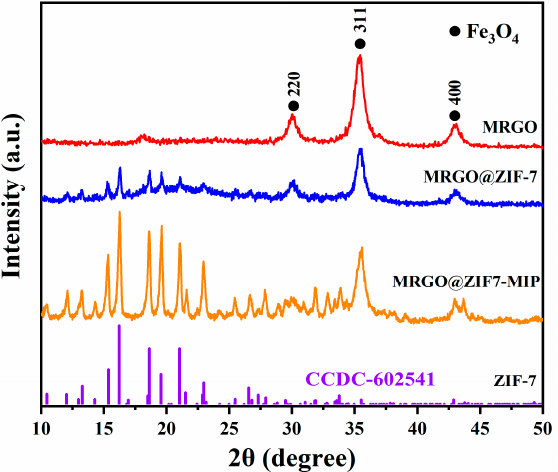
Figure 2. XRD patterns of MRGO, MRGO@ZIF-7 and MRGO@ZIF7-MIP.